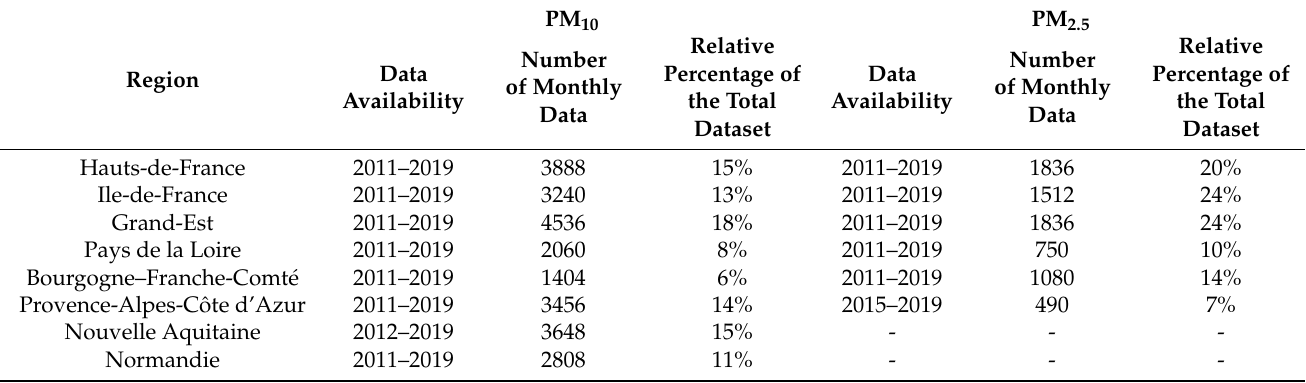
Table 1. Summary of the available